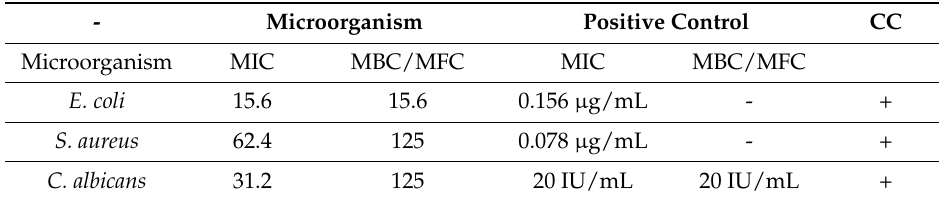
Table 2. Antimicrobial activity of Artemisia vulgaris essential oils against Staphylococcus aureus, Escherichia coli, and Candida albicans *. - Microorganism Positive Control CC